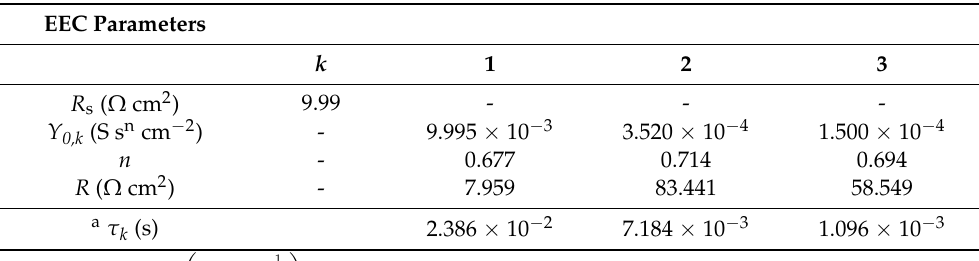
Table 5. Final EEC parameter values obtained by using EEC R(QR)(QR)(QR) and the automatic update limit strategy. The values are obtained by fitting the ZARC data (Figure 4).